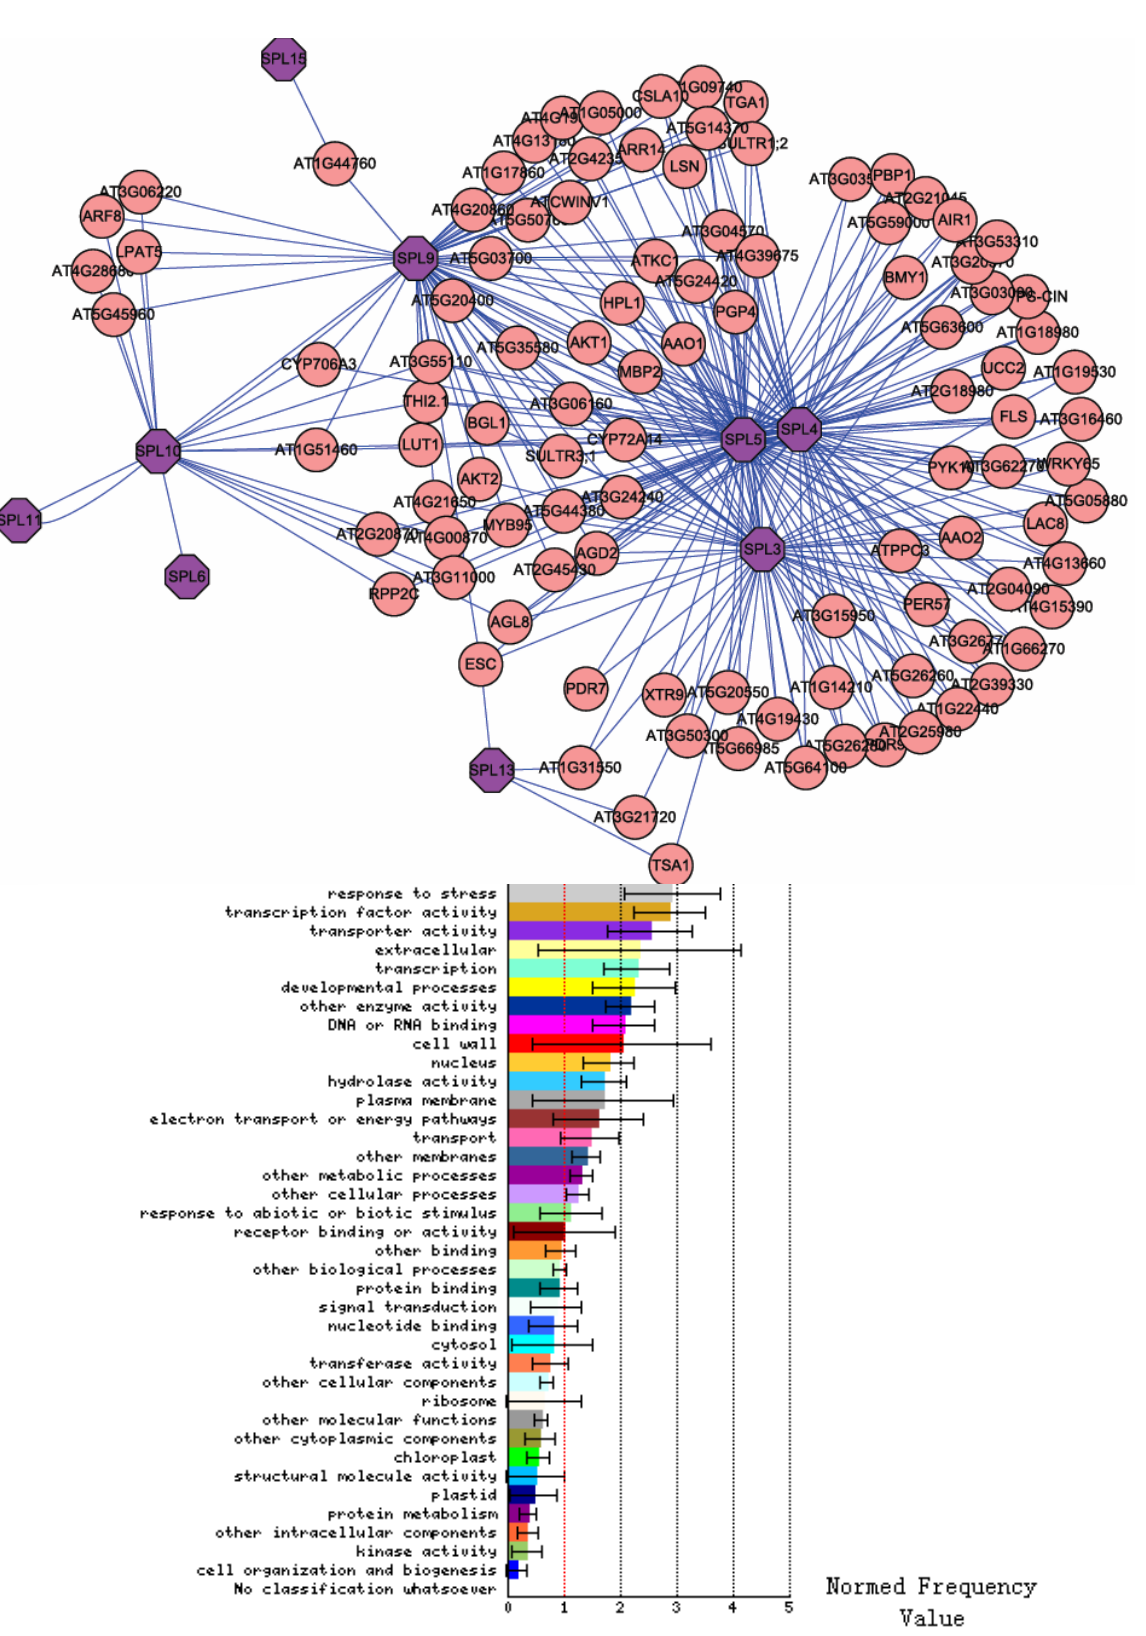
Figure 1 . Co-expression network and GO analysis of SPL genes. (A) A network composed of SPL and correlated genes. GO analysis shows that the network is involved in extensive functions. (B) A complex within the co-expression network and its